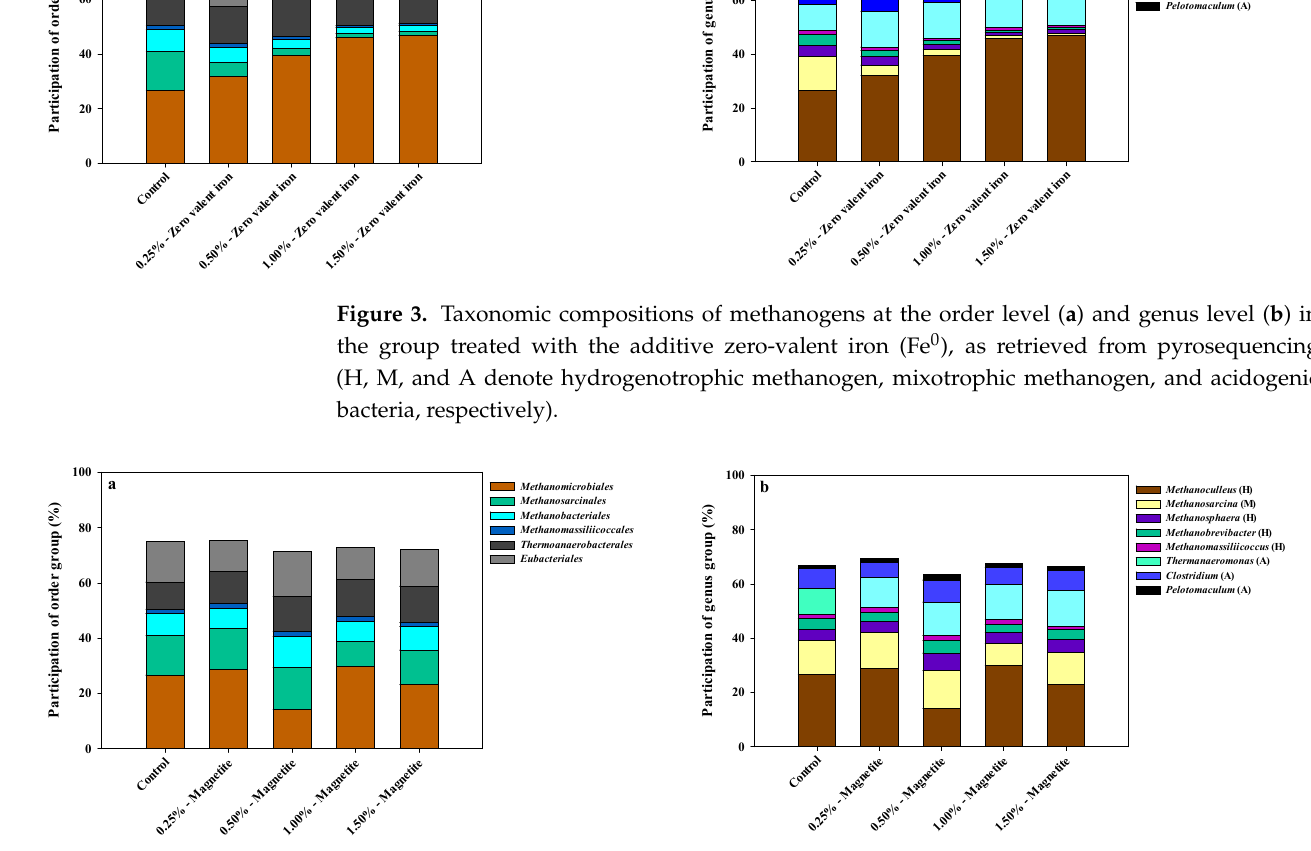
Figure 4. Taxonomic compositions of methanogens at the order level ( a ) and the genus level ( b ) in the group treated with magnetite (Fe 3 O 4 ), as retrieved from pyrosequencing (H, M, and A denote hydrogenotrophic methanogen, mixotrophic methanogen, and acidogenic bacteria, respectively). Jang et al. [55] reported that during the operation of batch anaerobic digesters for food wastewater, the portion of the Methanosarcinales colony (mixotrophic methanogen) decreased from 81.3% in the early stages of anaerobic digestion to 54% in the later stage, while Methanomicrobiales (hydrogenotrophic methanogen) increased from 11% in the ini- tial stage of anaerobic digestion to 25% in the later stage. Lee et al. [56] reported that Meth- anoculleus (hydrogenotrophic methanogen) accounted for 78.6% of the distribution in the operation of a continuous anaerobic digester of food wastewater, while that of Methano- sarcina (mixotrophic methanogen) amounted to 1.2%. This indicates that the colony distri- bution of a methanogen during the anaerobic digestion of food waste also varies with the duration of the operation of the anaerobic digester. Therefore, the increase in the colony distribution of the hydrogenotrophic methanogen with respect to the addition of conduc- tors for the anaerobic digestion of food may be a general trend in the operation of anaer- obic digesters. The characteristics of the colonization change in the anaerobic food digester and the increase in the colony distribution of the hydrogenotrophic methanogen in re- sponse to the addition of a conductor are believed to be related.